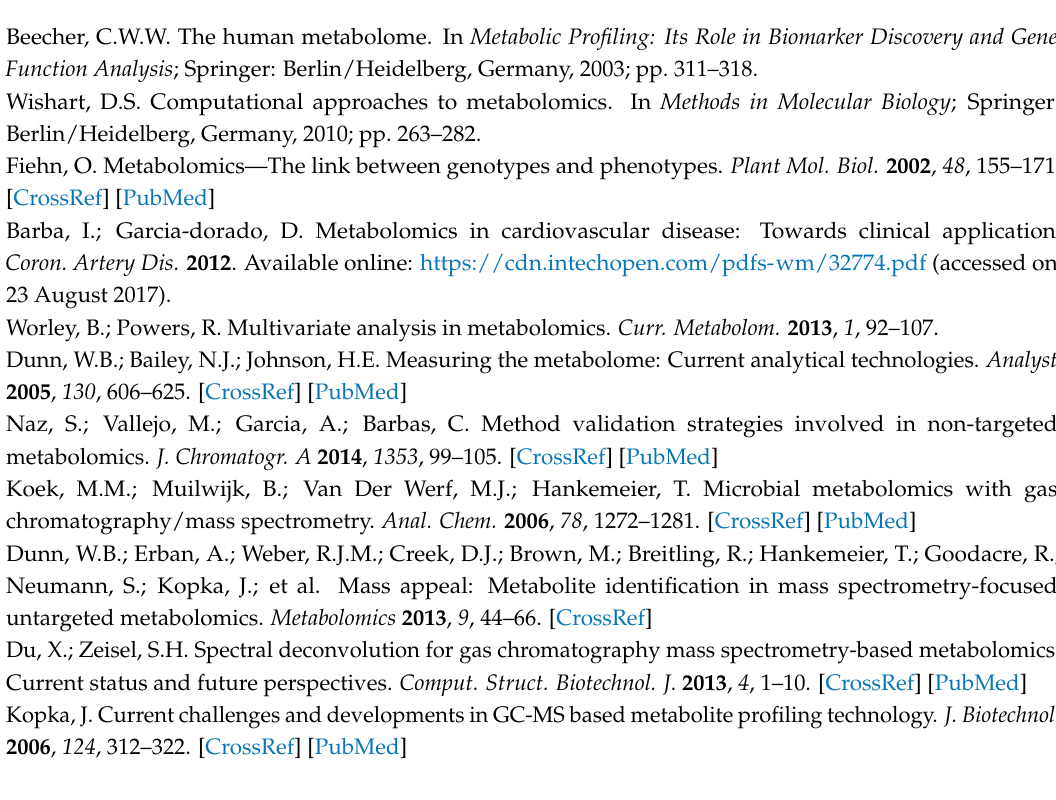
Figure S1: Example of positive (left) and negative (right) run order effect on contaminant levels. Contaminant on the left is an unknown with retention time 8.125 min; contaminant on the right is beta-monopalmitin, Table S1: Non-metabolite known contaminants detected in blanks, Table S2: Known analytes identified in the volunteer and NIST SRM 1950